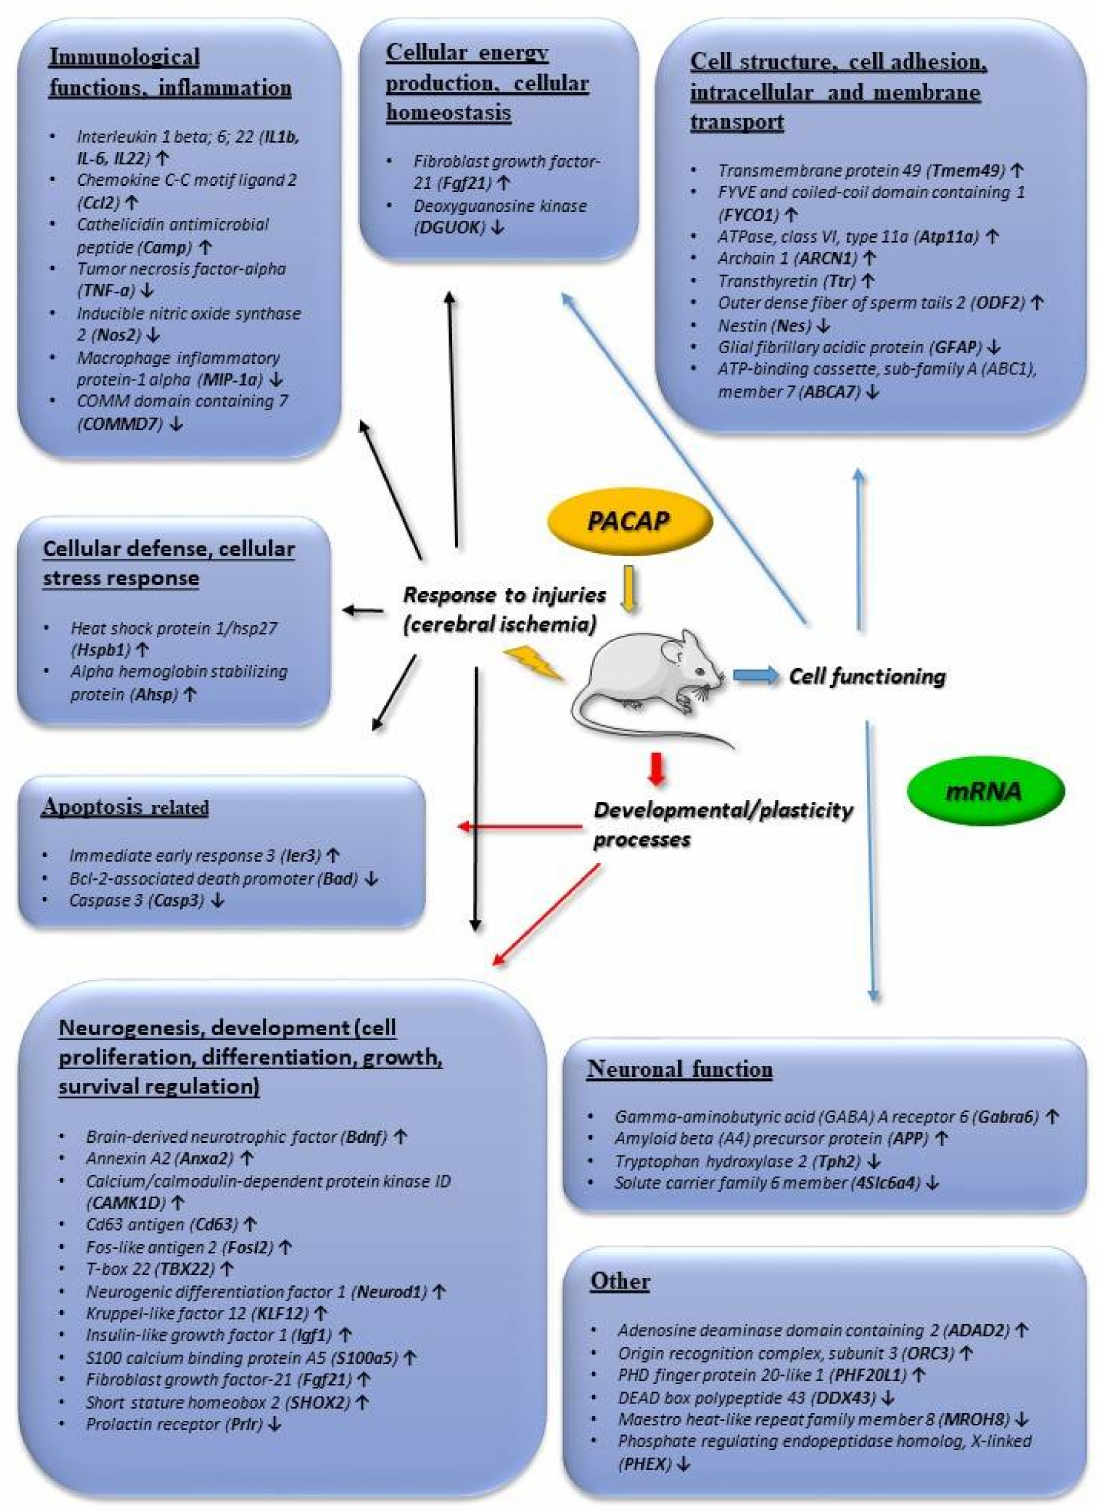
Figure 2. Main in vivo transcriptomic changes induced by PACAP. Arrows indicate main up or downregulated genes. The data in the figure come from the references: